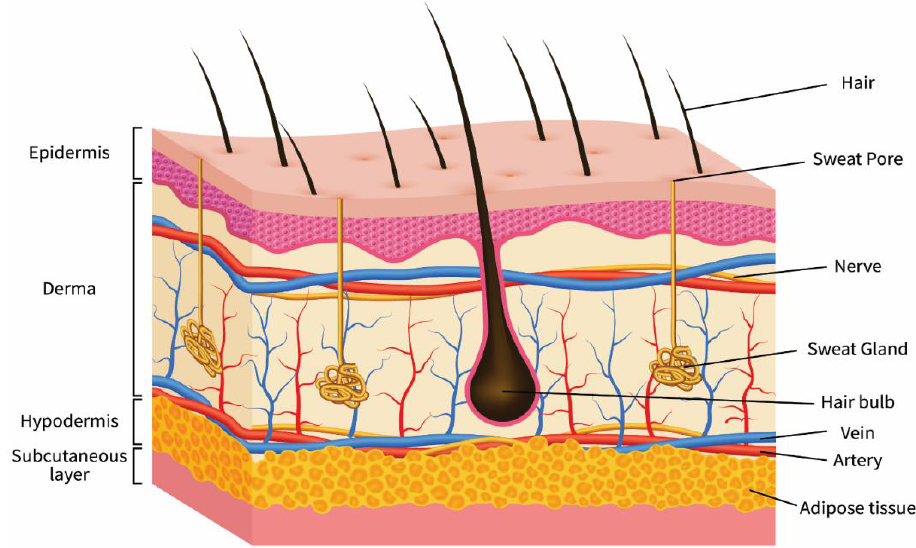
Figure 2. A diagrammatic illustration of a three-dimensional (3D) structure of the skin.